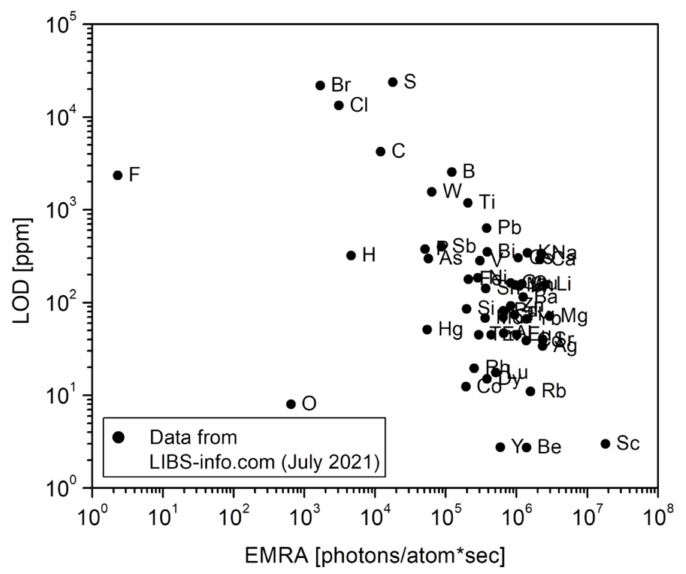
Figure A4. Correlation of reported LOD values for LIBS analysis of solid materials with calculated emission rate EMRA of LIBS plasma for various elements. The sign “*” stands for multiplication. Figure A5 shows the total number of smartphones sold to end-users in the time period 2007 to 2021 (values for 2020 and 2021 are estimates) [432].